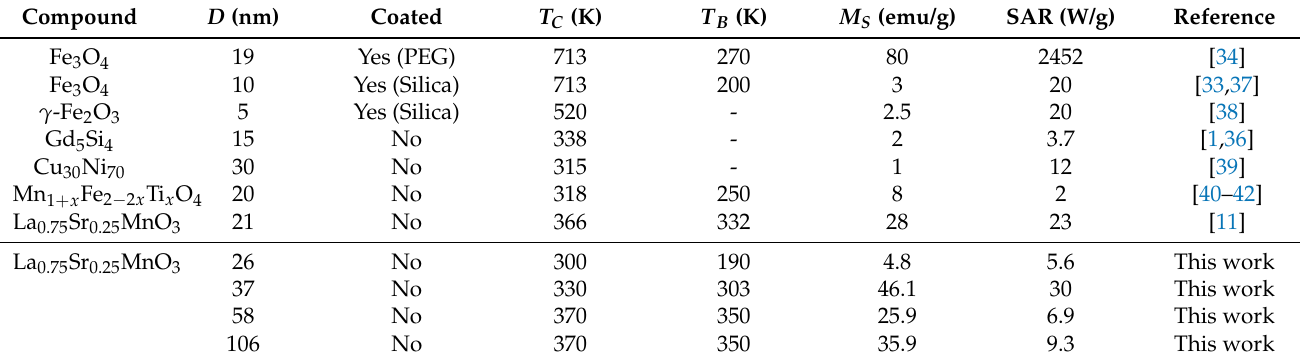
Table 2. Summary of suitable parameters of nanoparticles from the literature with potential for hyperthermia applications: Diameter ( D ), type of coating, Curie temperature ( T C ), blocking temperature ( T B ), saturation magnetization ( M S ) and specific absorption rate